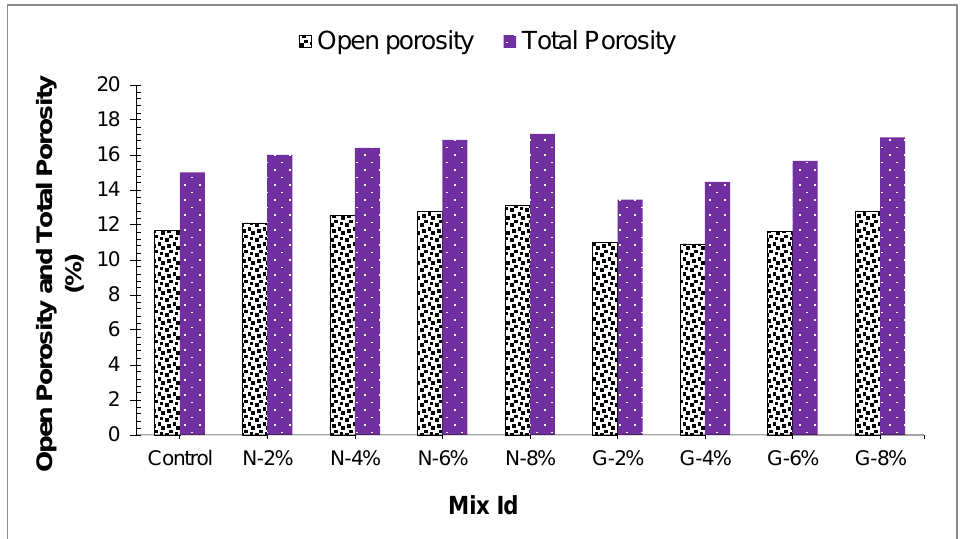
Figure 17. Open porosity and Total porosity of concrete samples.